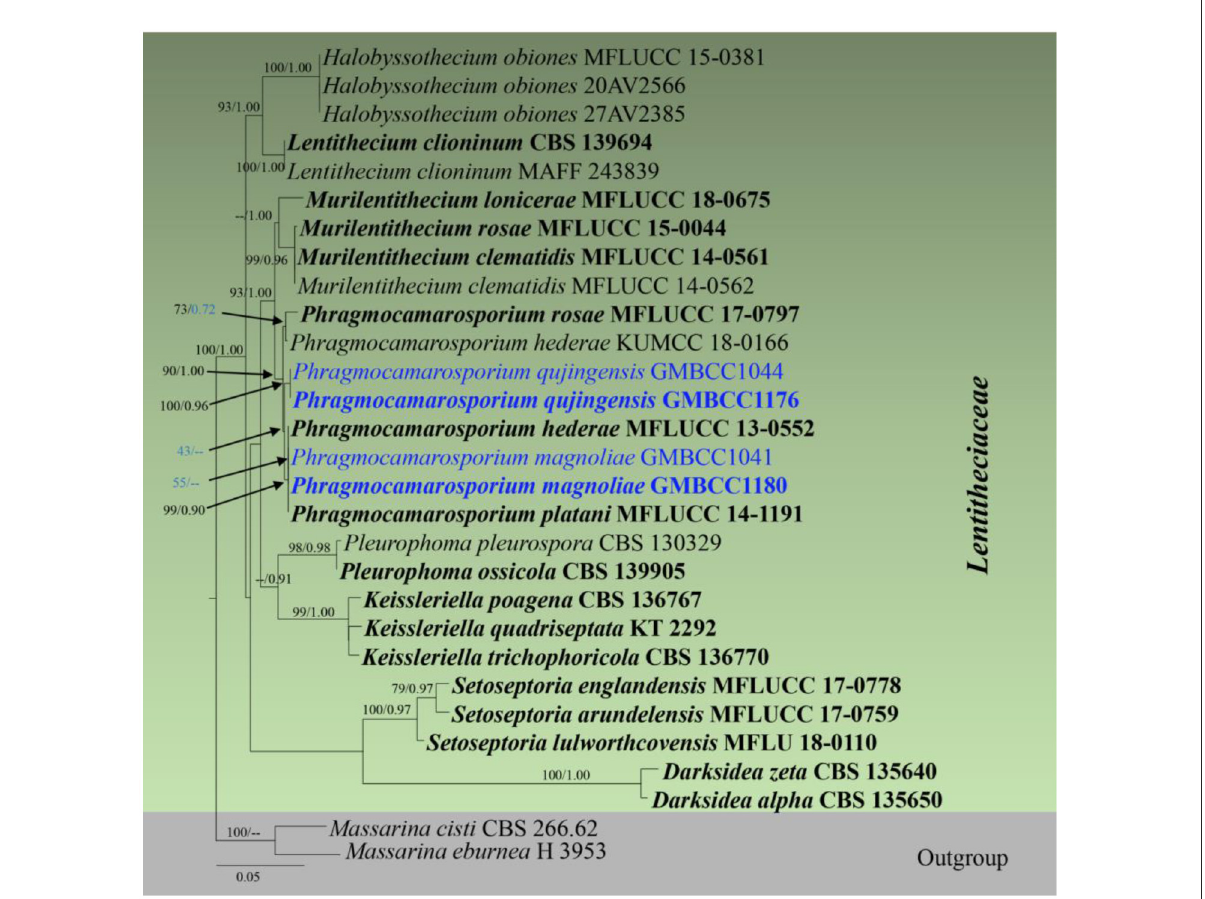
FIGURE3 RAxML tree based on a combined dataset of partial SSU, LSU, tef1 , and ITS DNA sequence analyses. Bootstrap support values for ML equal to or > 50% and Bayesian posterior probabilities (BYPP) equal to or > 0.9 are shown as ML/BI above/below the nodes (except for those values in blue in Phragmocamarosporium clade). The type of strains is in bold, and new isolates are in blue. The scale bar represents the expected number of nucleotide substitutions per site.